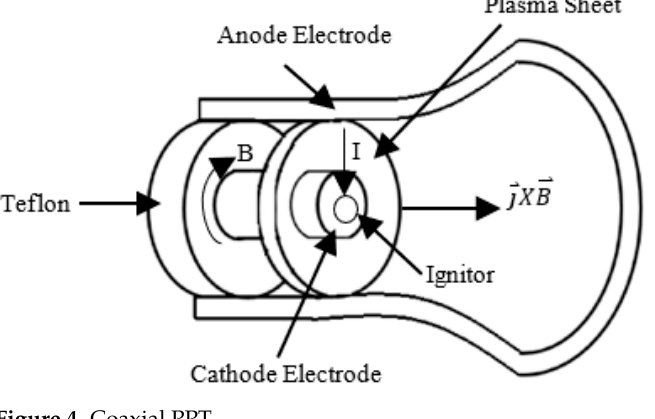
Figure 4. Coaxial PPT.